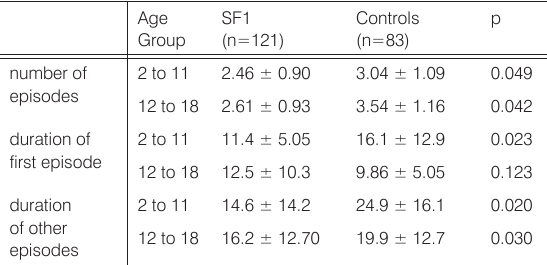
Table 2. Number and duration of sinusitis episodes with therapy (mean ± SD)